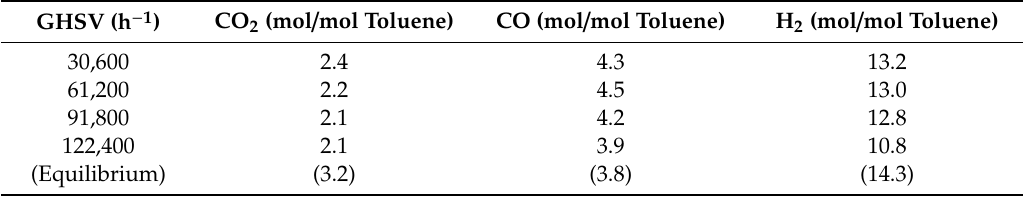
Table 3. Product yields for the gaseous products at di ff erent GHSV (S / C:3, 800 ◦